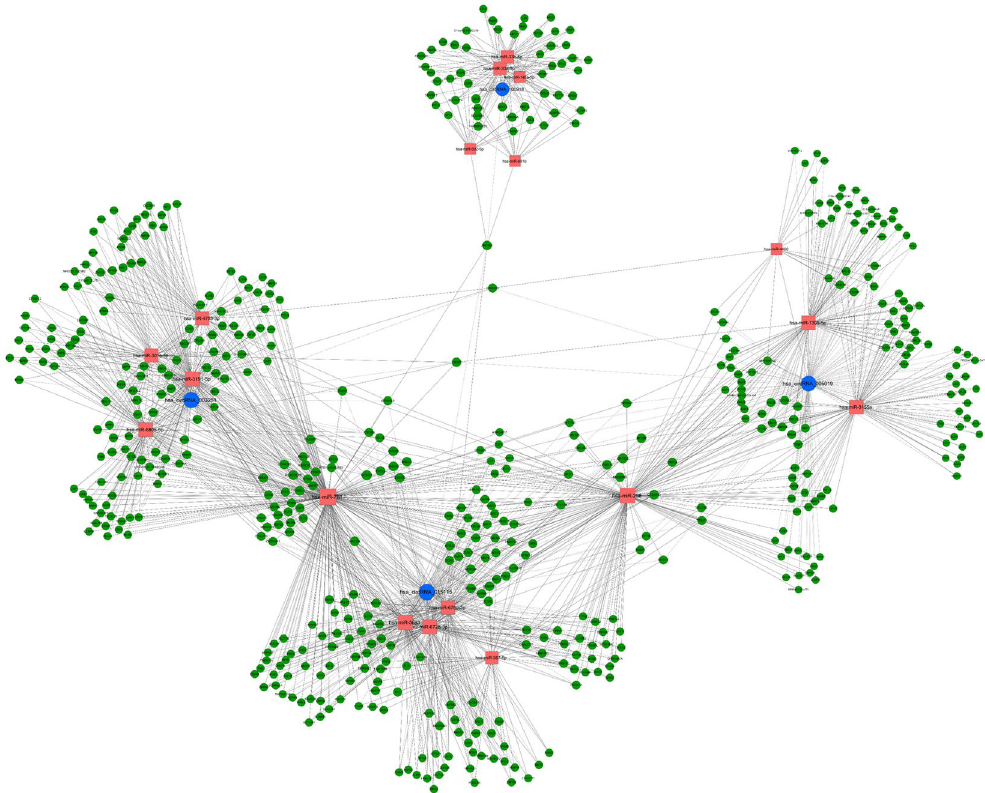
Figure 4. CircRNA/miRNA/mRNA network. Blue circle nodes: circRNAs; red square nodes: miRNAs; green circle nodes: